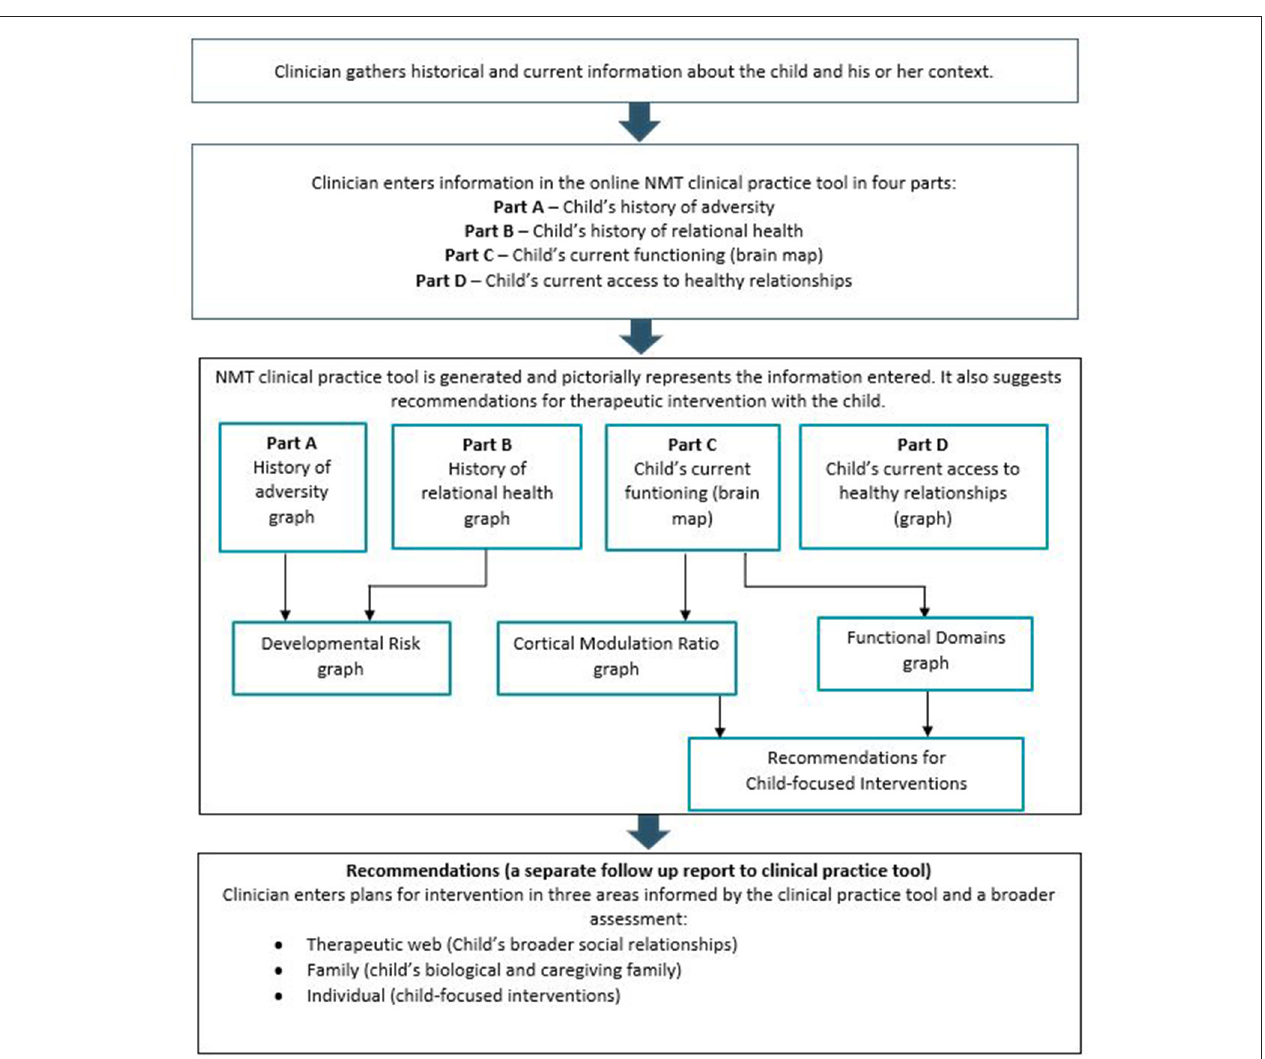
FIGURE 1 | An overview of the NMT process. Jackson et al.